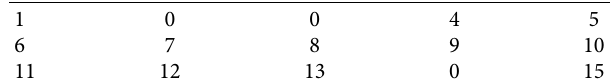
Table 3: T ″ corresponding to T in Table